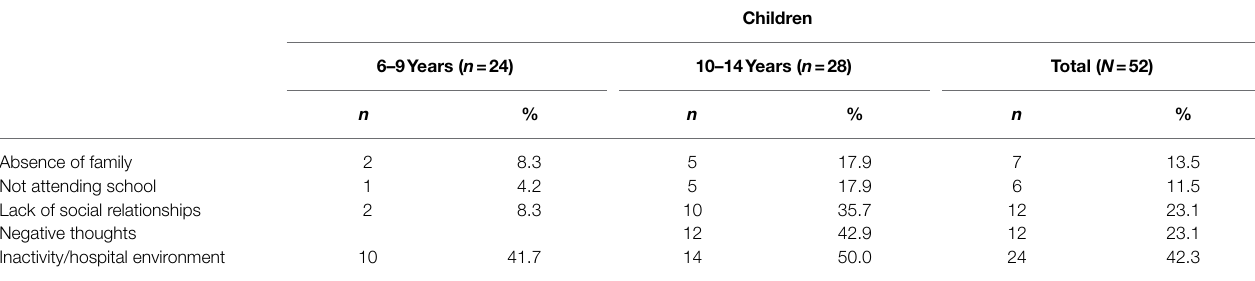
TABLE 4 | Factors related to negative emotions during hospitalization.